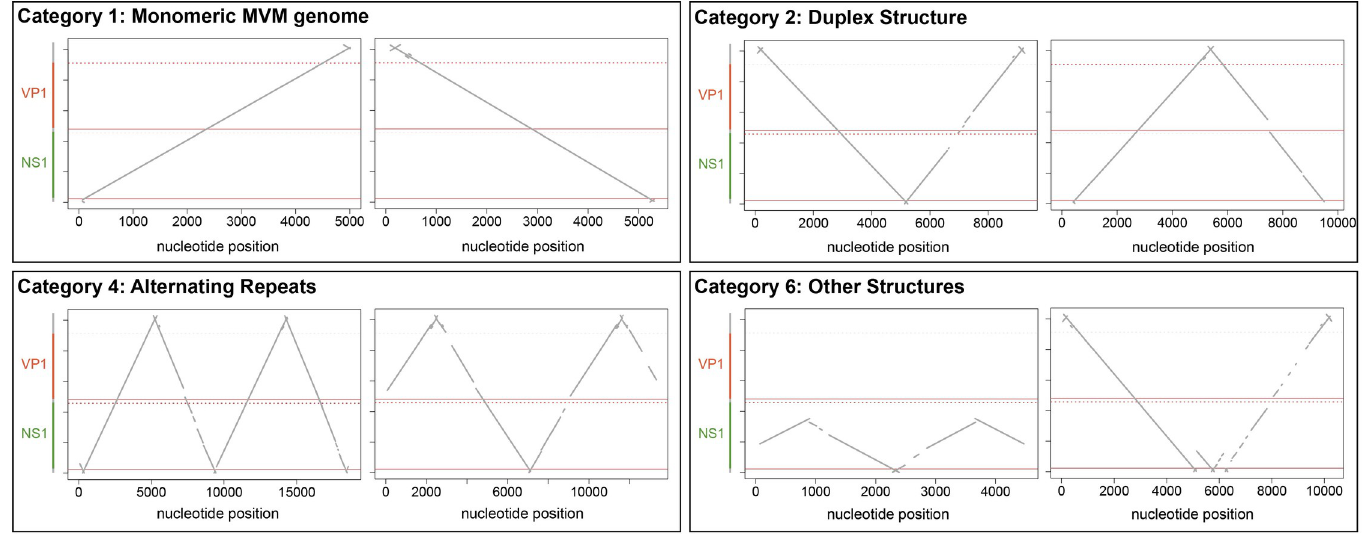
Fig 4. MVM replication intermediates. Dot plots of two representative individual reads per category from MVM infected A9 cells are shown. Extrachromosomal DNA was isolated at 16 hpi from A9 cells infected with MVM (MOI = 1’000).